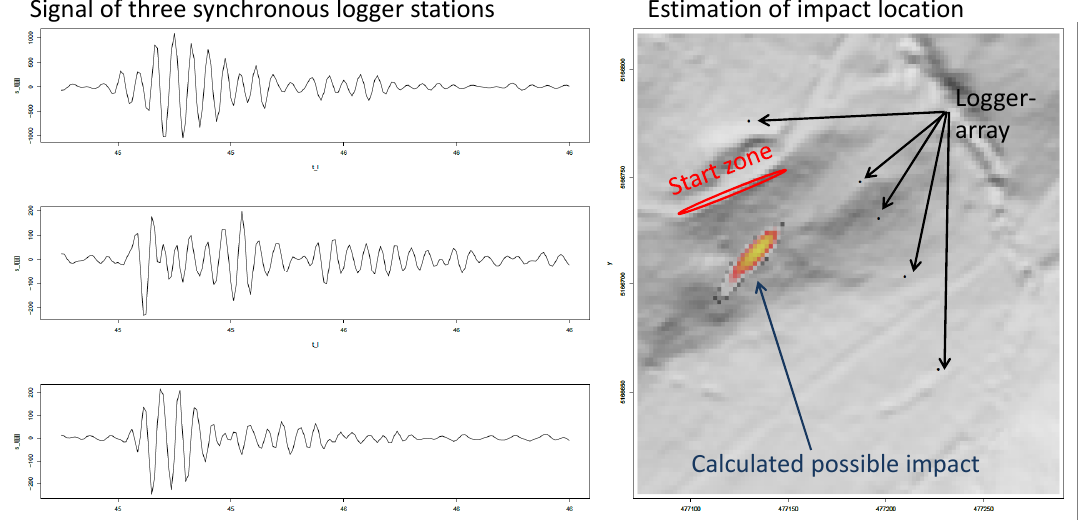
Figure 16. A single impact during Test 109, detected by installed seismo array loggers: on the left the signals detected by three synchronized logger stations are shown over time; on the right the estimated impact location is shown with respect to the location of the logger stations (source: M. Dietze, GFZ